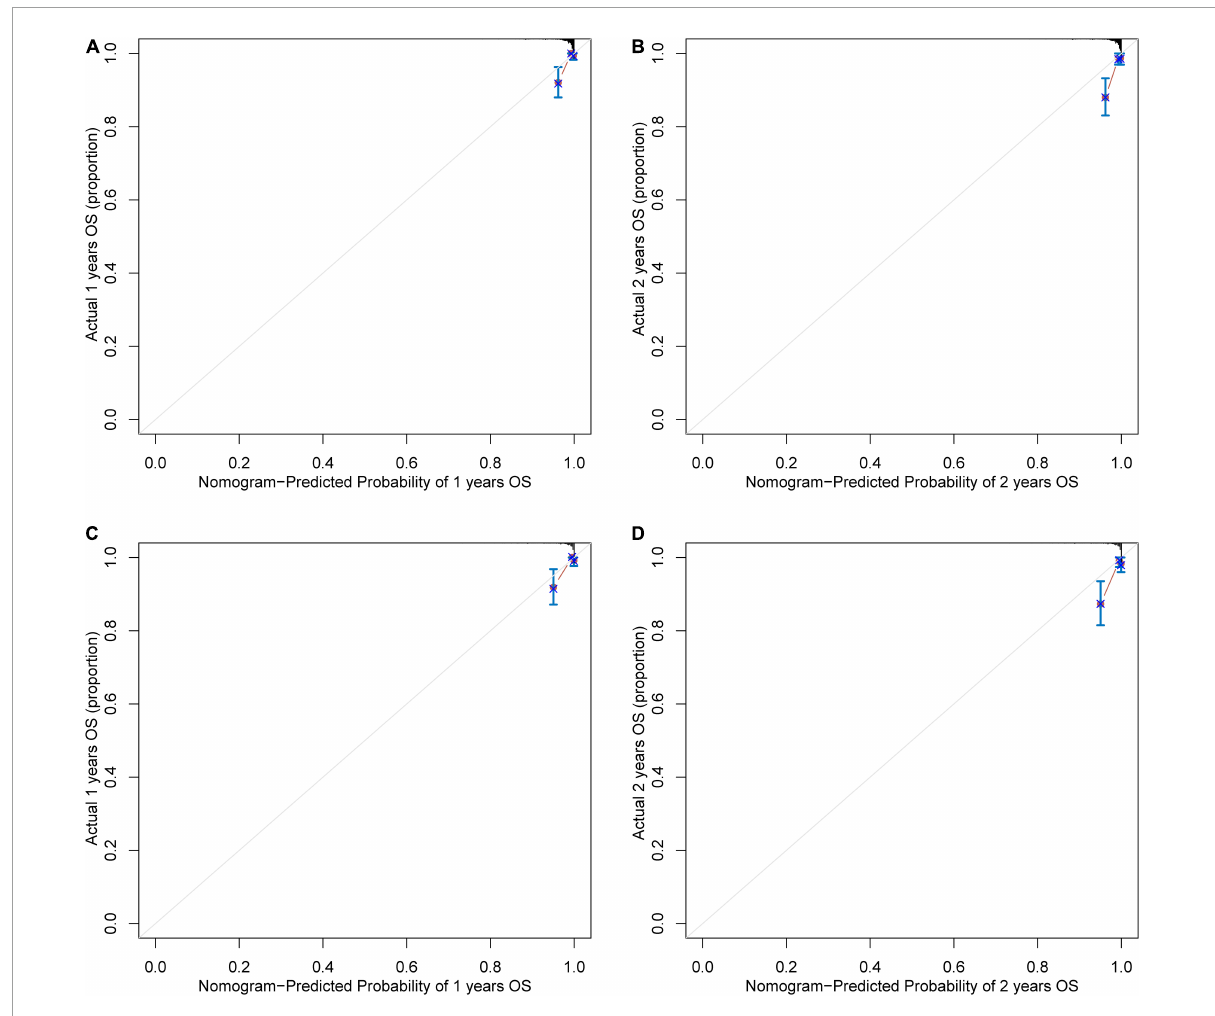
FIGURE6 The calibration curve for survival prediction at (A) 1 year and (B) 2 years in the overall population and at (C) 1 year and (D) 2 years in the validation cohort. The nomogram-predicted probability of overall survival is plotted on the x-axis; the actual overall survival is plotted on the y-axis. OS, overall